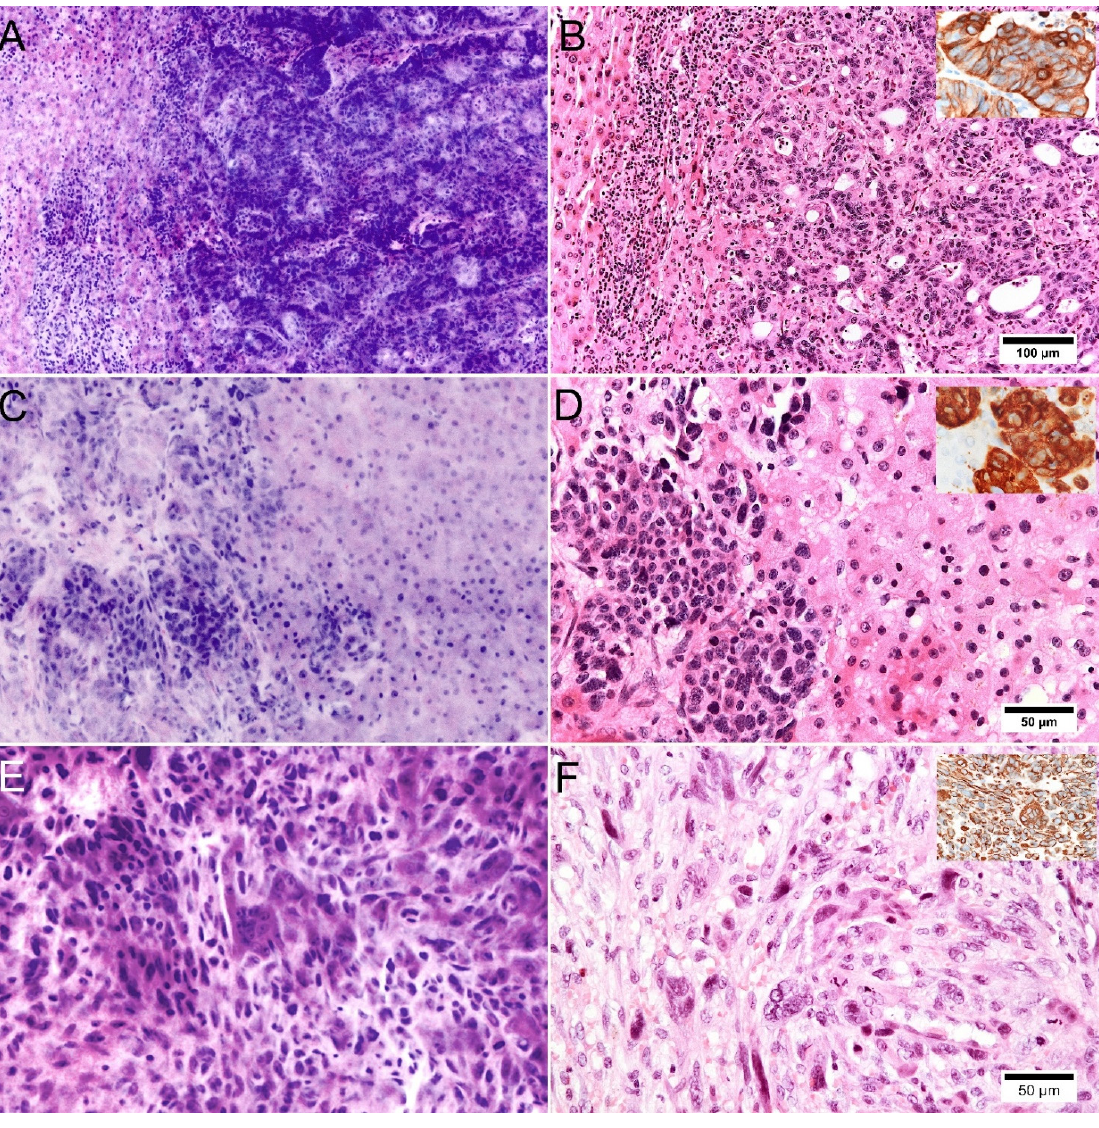
Figure 4. Representation of metastatic neoplasms of the liver in FCM scans. ( A , B ): Metastasis of colorectal carcinoma in FCM ( A ) and conventional histology (( B ), HE staining). Typical glandular patterns of the primary tumor were preserved in this case and clearly recognizable in the FCM scans. Characteristic expression of Cytokeratin 20 (inlay) was preserved in the material. ( C , D ): Liver biopsy with focal manifestations of poorly differentiated neuroendocrine carcinoma in FCM ( C ) and conventional histology, (( D ), HE staining) showing no characteristic features. Immunohistology showed preserved expression of neuroendocrine markers (Chromogranin A, inlay). ( E , F ): Metastasis of dedifferentiated pancreatic carcinoma in FCM ( E ) and conventional histology (( F ), HE staining) presenting sarcomatoid morphology. Immunohistology (Vimentin, inlay) was not helpful in this case. The final diagnosis was established with knowledge of the pancreatoduodenectomy